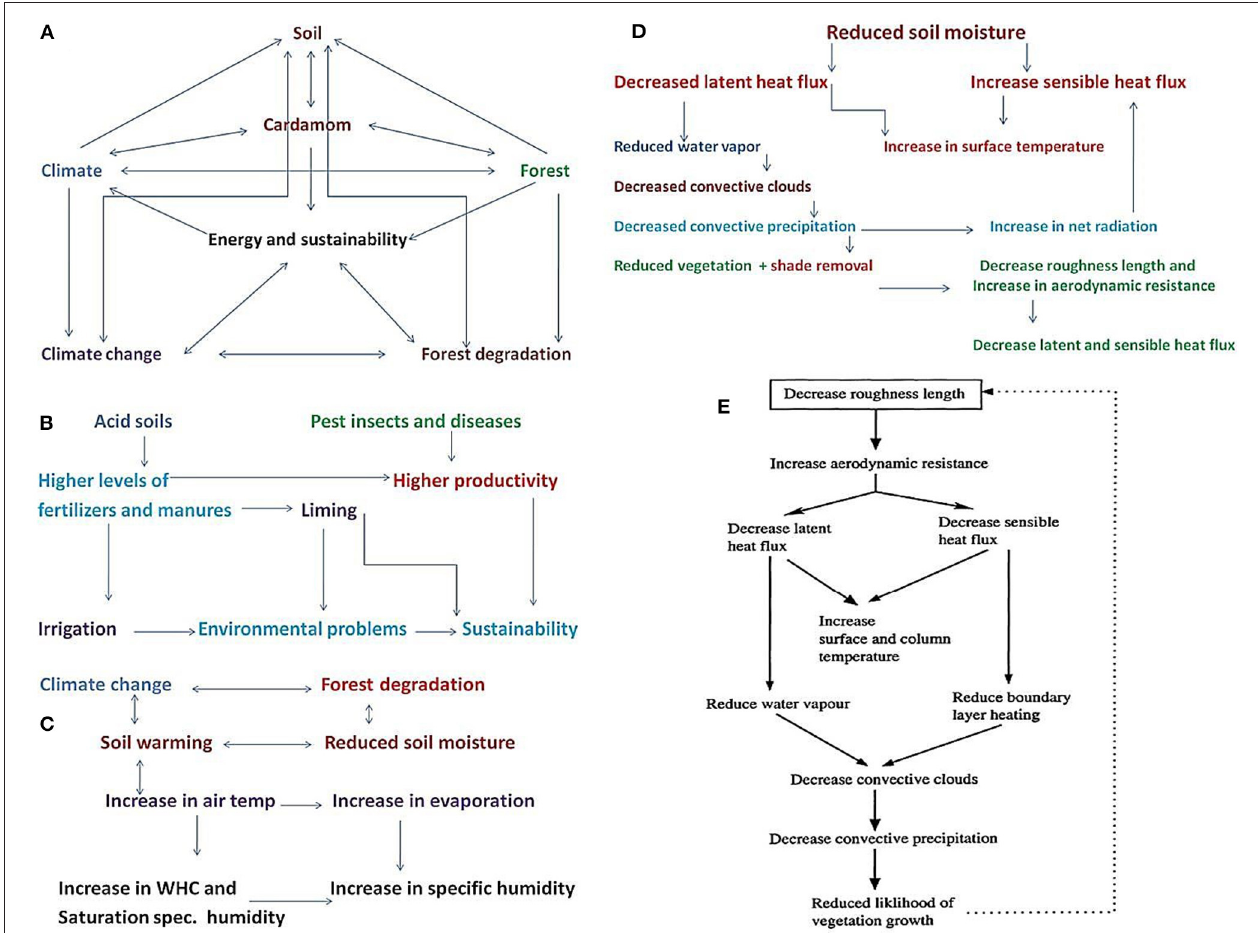
FIGURE 1 | Schematic diagrams showing the linkages as well as cause and effects of the climatic variables due to forest degradation in cardamom cultivation. (A) The nexus of climate-cardamom-forest system. (B) Influencing factors and their relationships with cardamom production. (C) Impact of forest degradation on